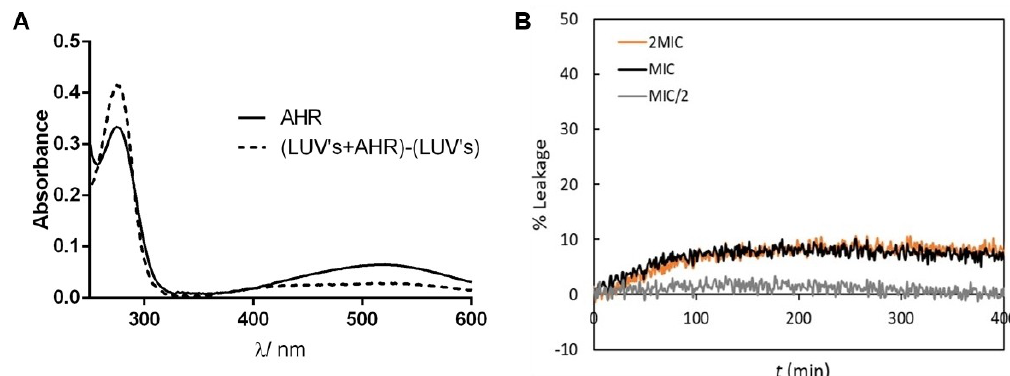
Figure 8. AHR at relevant antimicrobial concentrations interacts with phospholipid bilayers without compromising their integrity. ( A ) Electronic absorption spectrum of AHR at 20 µM in buffer Tris-HCl, pH 7.4 in the absence and presence of 1mM 1,2-dioleoyl- sn -glycero-3-phosphocholine (DOPC) large unilamellar vesicles (LUV) suspension. ( B ) Representative curves (median behavior from 6 independent experiments) of the effect of AHR on CF leakage from DOPC LUVs in suspensions, with a total lipid concentration of 0.5 mM, in the presence of different AHR concentrations: 15.6 mg/L (2 MIC, 40 µM), 7.8 mg/L (MIC, 20 µM) and 3.9 mg/L (MIC/2, 10 µM). These experiments were performed at 25 °C.